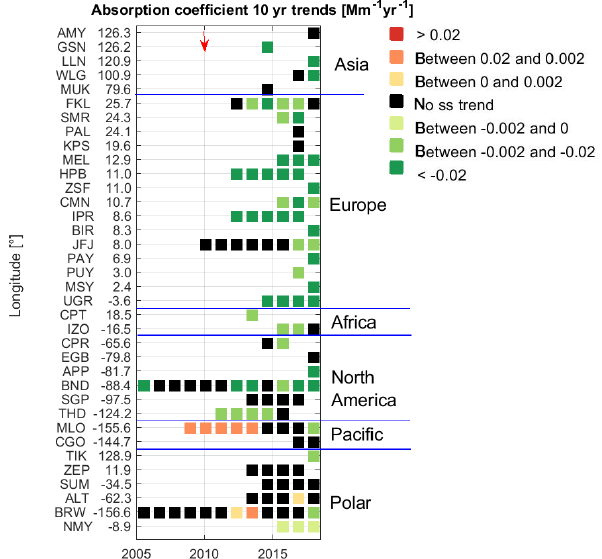
Figure 13. Time series of sequential 10-year σ ap trends as a func- tion of station longitude. The red arrow indicates the end of the time period covered in CC2013.